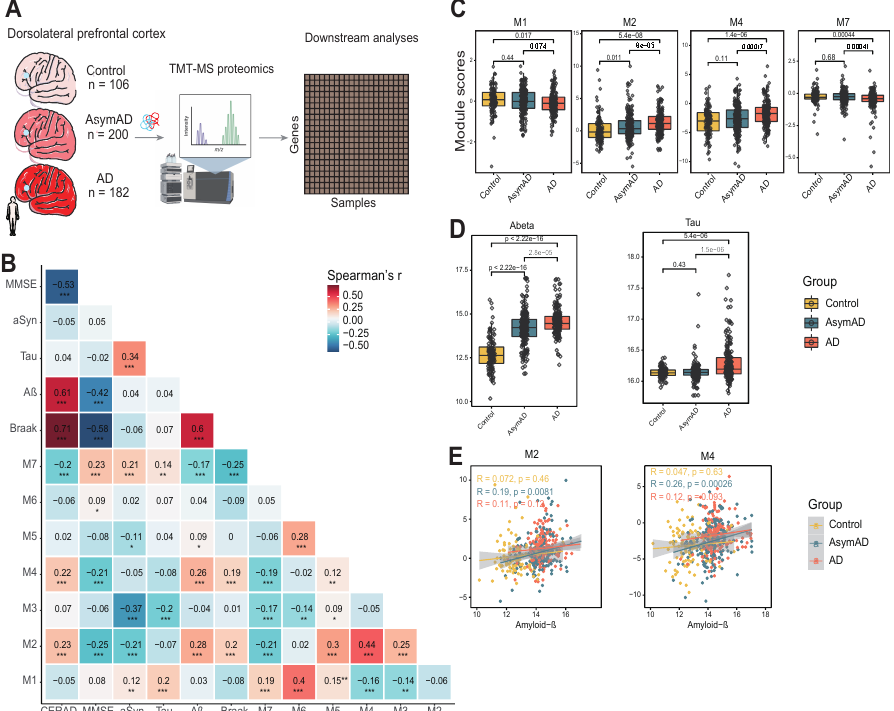
Figure 6. Astrocyte transcriptomic modules were validated at the protein level. ( A ) Workflow of TMT-MS-based proteomics on dorsolateral prefrontal cortex (DLPFC) tissues from control (N = 106), asymptomatic AD (AsymAD, N = 200), and AD human brains (N = 182). ( B ) Heatmap shows module relatedness, and modules were correlated with neuropathological and cognitive traits. Correlation coefficients were asserted based on Spearman correlation (red, positive correlation; blue, negative correlation). * p < 0.05, ** p < 0.01, and *** p < 0.001. Amyloid plaque load (CERAD score), tau neurofibrillary tangle burden (Braak stage), cognitive function (Mini-Mental Status Examination, MMSE), and mass spectrometry molecular measurements (A β ; tau, the tau microtubule-binding region; α Syn). ( C ) Boxplots showing module score levels by case status. p -values are derived from a two-sided Wilcoxon test. ( D ) Boxplots showing A β and tau levels by case status. p -values are derived from a two-sided Wilcoxon test. ( E ) A β levels were correlated with M2 and M4 module scores by case status. Correlation coefficients were asserted based on Spearman correlation, colored by case